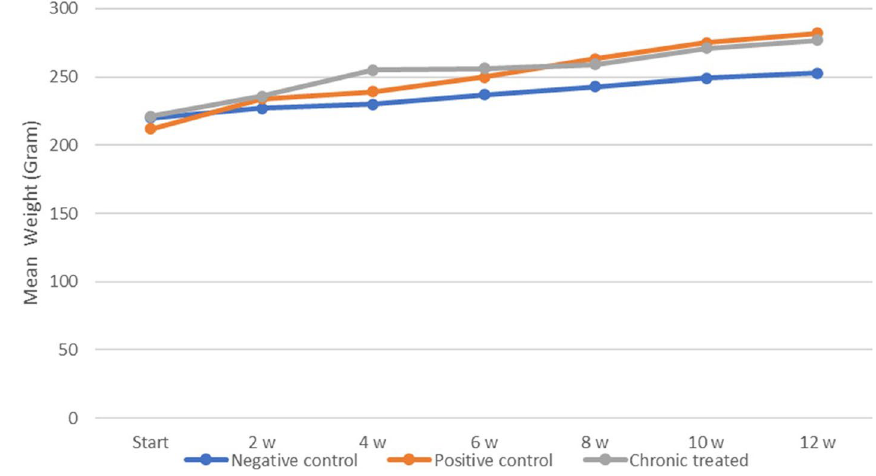
Fig. 2 Line chart demonstrates the difference in animal weight during periods of observation in the chronic